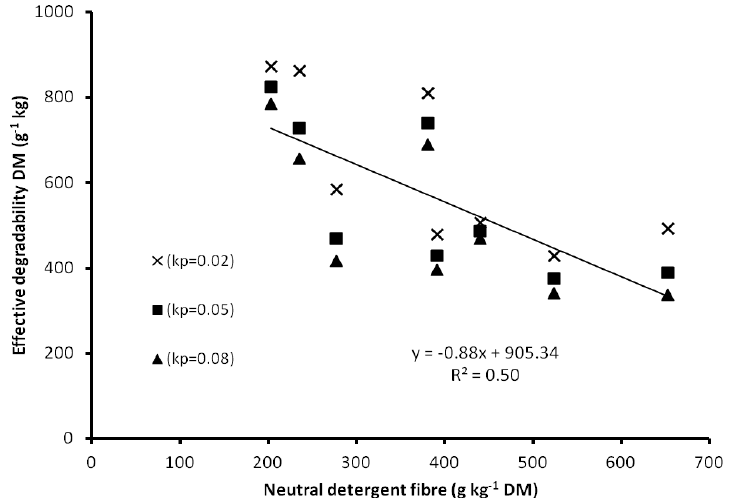
Figure 1. Effective degradability of dry matter (DM) (ED DM ) of oilseed press cakes, soybean meal and glycerine in terms of neutral detergent fibre (NDF) concentration (g/kg DM).